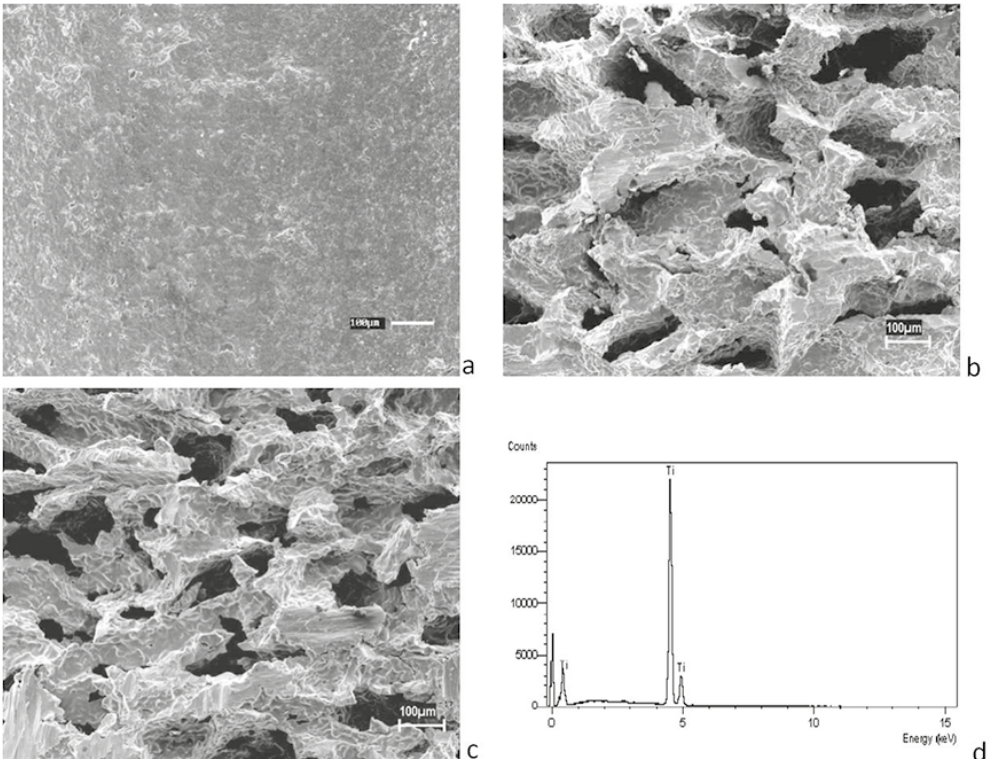
Figure 2. SEM image of pure Ti: a) dense sample; b) 30% porous sample; c) 40% porous sample; d) EDS results.